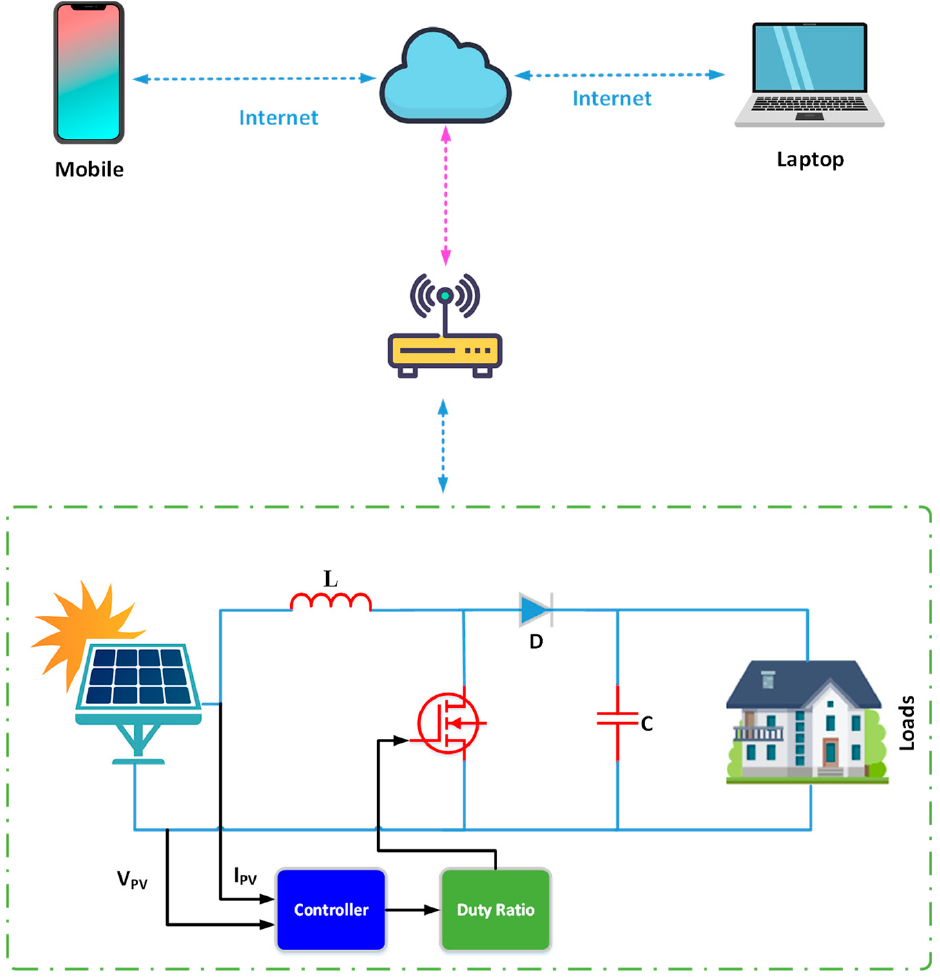
Figure 1. Structure of proposed system.